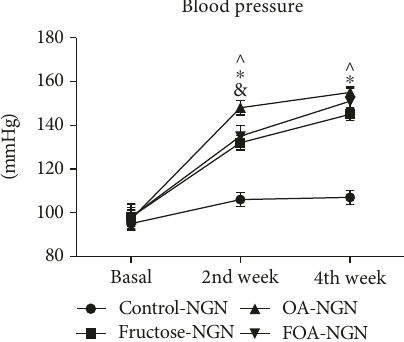
Figure 1: Systolic blood pressure in NGN groups at basal time, 2nd week, and 4th week after the beginning of treatment. NGN: normogonadic; OA: oxonic acid; FOA: fructose and oxonic acid. & p < 0 05 control versus FOA group at 2nd week. ∗ p < 0001 control versus fructose group at 2nd week and 4th week and OA versus FOA group at 2nd week. ∧ p < 0 0001 control versus OA group at 2nd week and 4th week and control versus FOA group at 4th week.